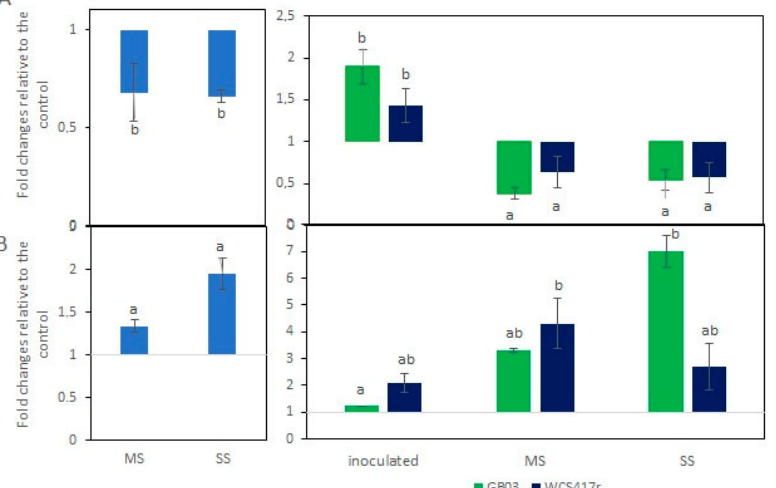
Figure 4. Limonene synthase ( Lim s ) ( A ) and pulegone reductase ( Pr ) ( B ) gene expression of pepper- mint plants subjected to moderate (MS) or severe drought stress (SS) and inoculated with different PGPR strains (mean ± SE). Values are fold changes relative to the control. Different letters indicate significant differences between treatments based on Fisher’s LSD test (n = 5, p < 0.05).